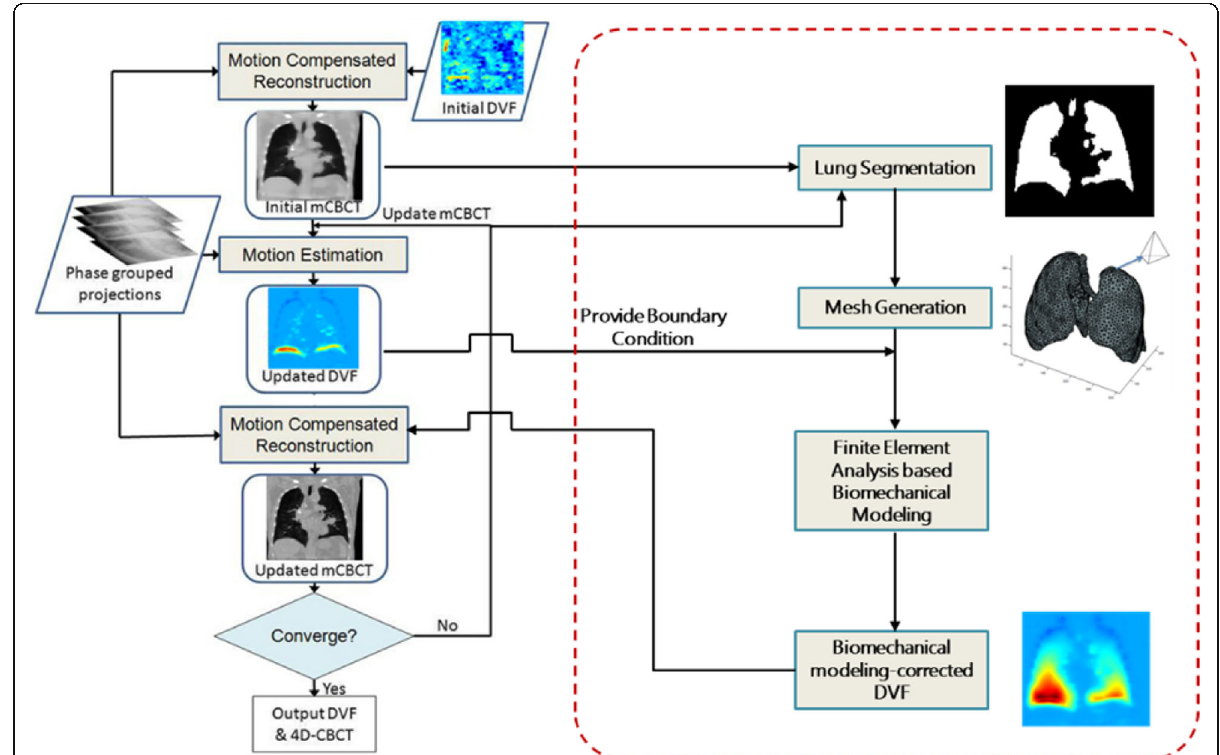
Fig. 3 The general flow of the biomechanical modeling-guided SMEIR scheme. 4D-CBCT: 4-Dimensional cone-beam computed tomography; DVF: Deformation-vector-field; mCBCT: Motion-compensated